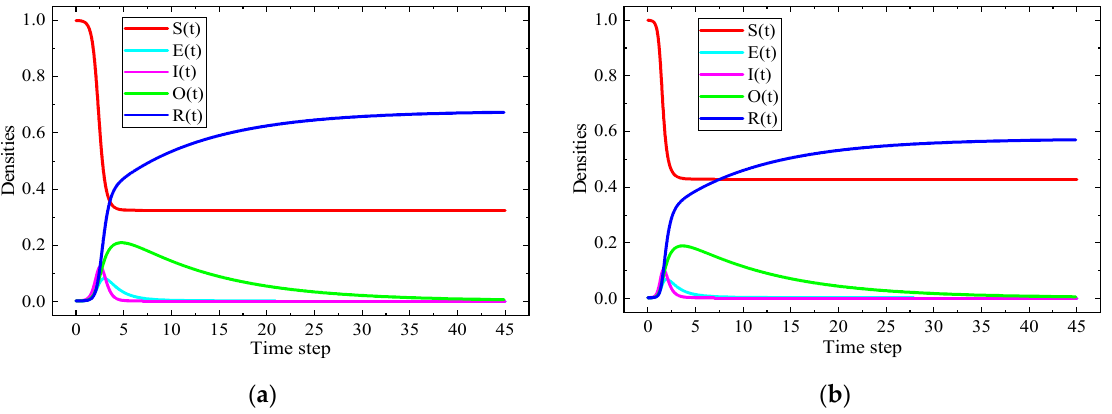
Figure 3. ( a ) Monte–Carlo solution results in WS small-world network; ( b ) Monte–Carlo solution results in BA scale-free network. Table 2. Model parameter settings during Monte–Carlo